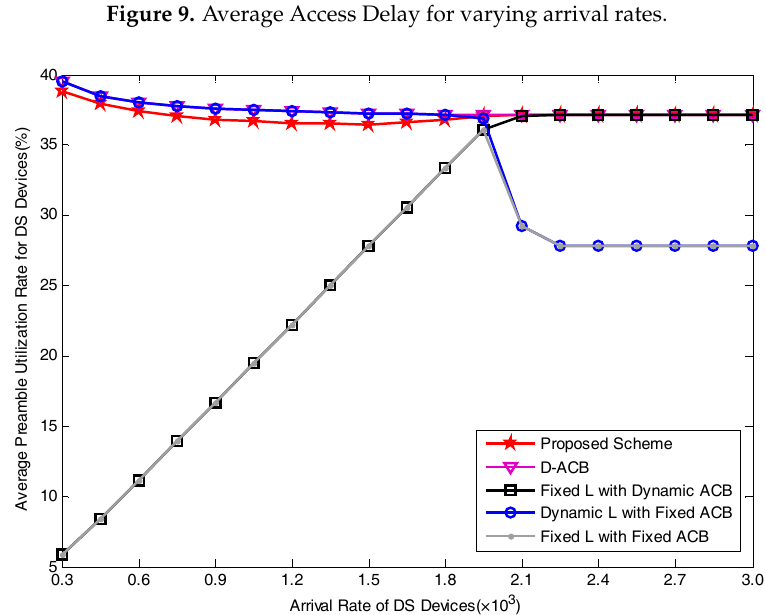
Figure 10. Average Preamble Utilization Rate for varying arrival rates.